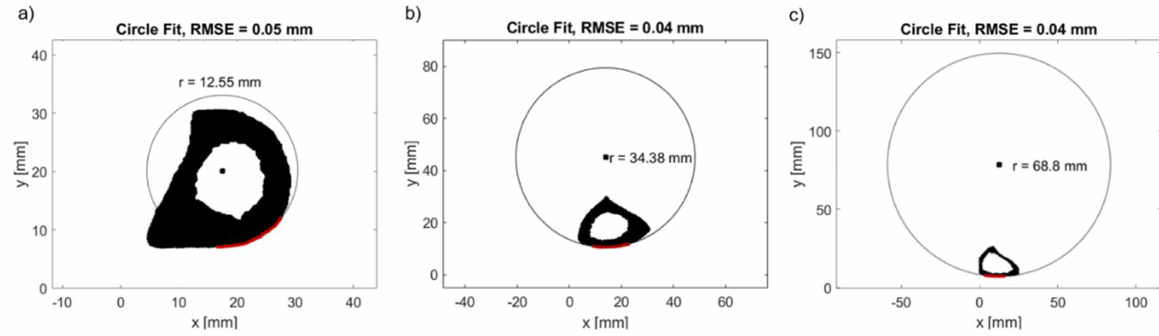
Figure A2. Three representative HR-pQCT scans of tibia midshaft bones of postmenopausal women. Circles were fitted to the anteromedial side to estimate the local bone surface radius. The red line indicates the central anteromedial tibia region, where ultrasound measurements were performed. The images in ( a – c ) show subjects with a minimum (12.6 mm), mean (34.38 mm), and maximum (68.8 mm) curvature radius,